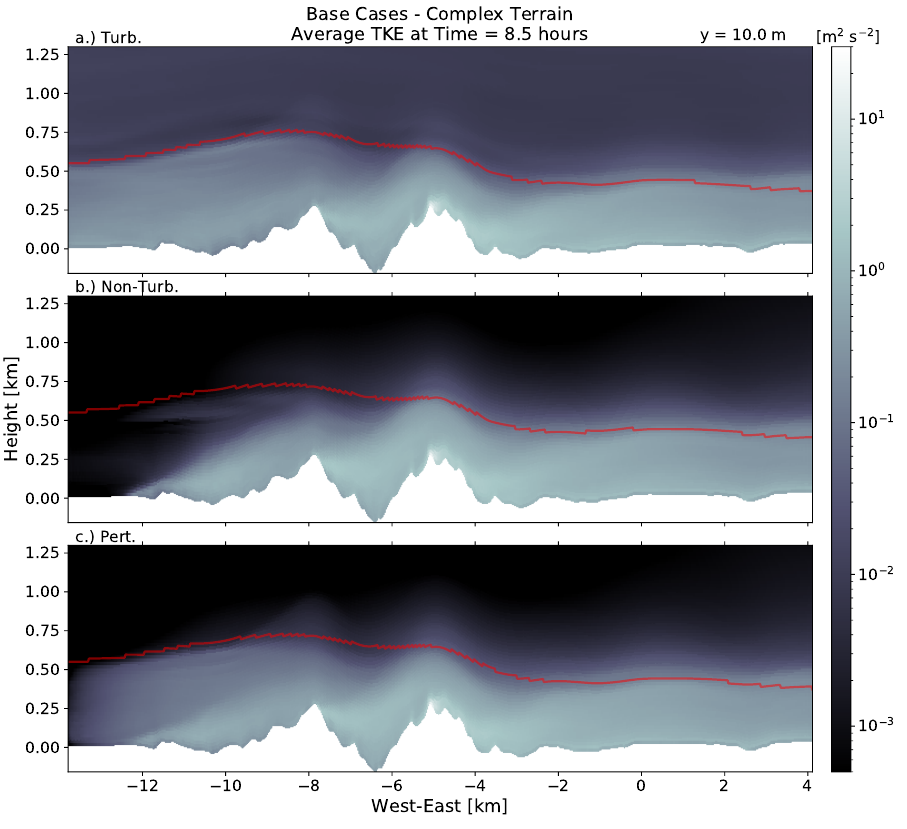
Figure 9. Same as in Figure 8 but with time-averaged TKE for the ( a ) Turbulent, ( b ) non-turbulent, and ( c ) cell perturbation simulations in the CXT_base